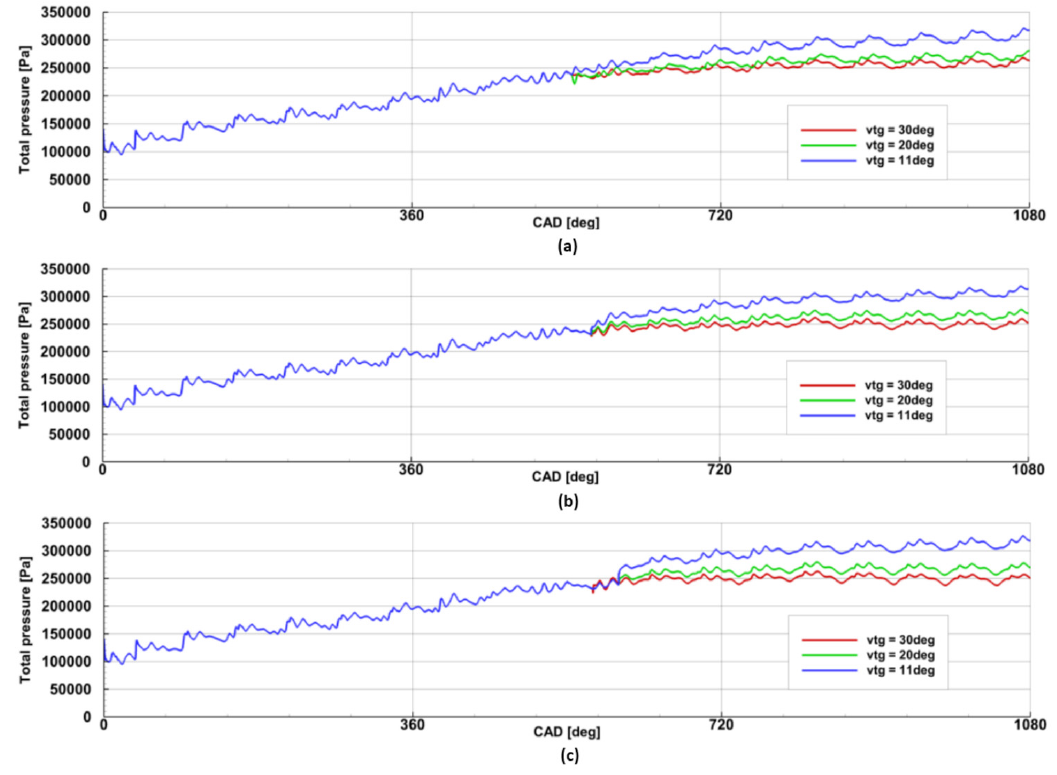
Figure 17. The outlet total pressure variation of the 1st stage rotor at the three different VTG openings for: ( a ) 60,000 rpm, ( b ) 50,000 rpm, ( c ) 40,000 rpm turbine speed.